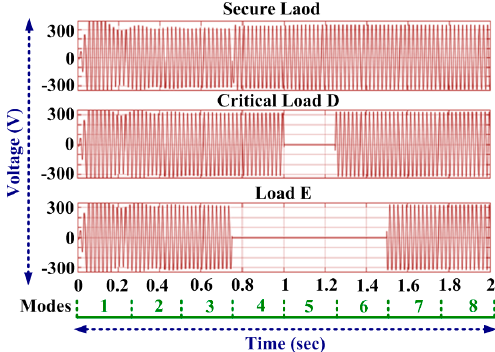
Figure 8. Output voltage of (top to bottom: secure load B, critical load D, and load E.